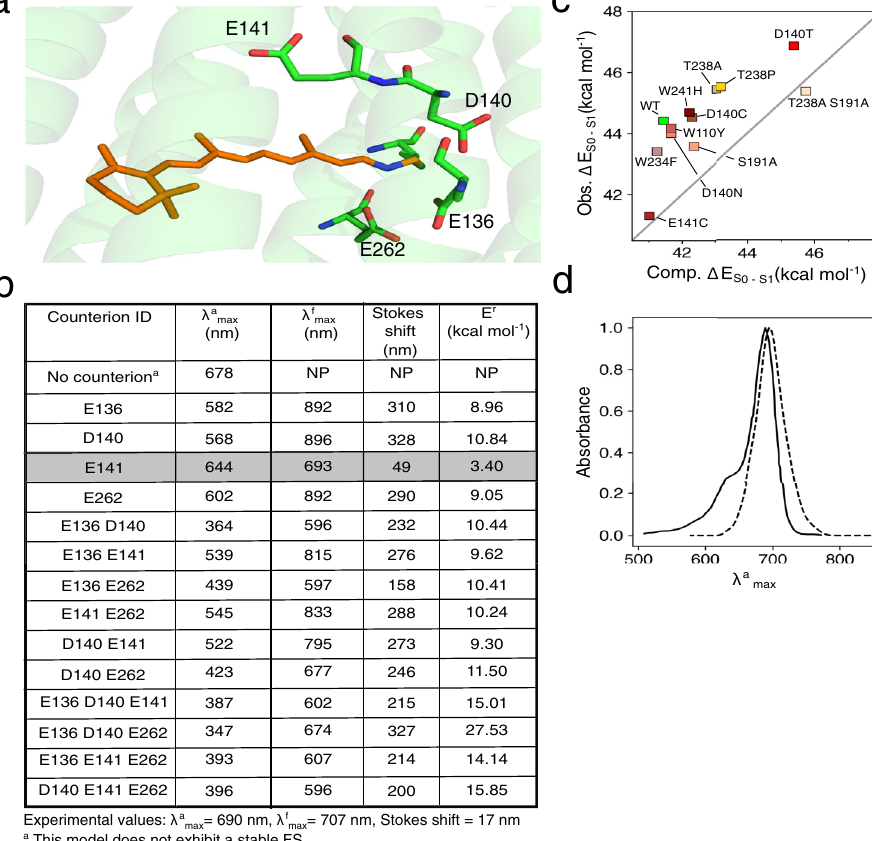
experimental (Obs. Δ E S0 – S1 ) and computed (Comp. Δ E S0 – S1 ) values of vertical excitation energies de fi ning λ a max in the wild type (indicated as WT) and a set of NeoR mutants. d Superimposition of experimental and computed (dotted line) absorption band of wild type NeoR. The experimental band has been digitalized from the corresponding ref.